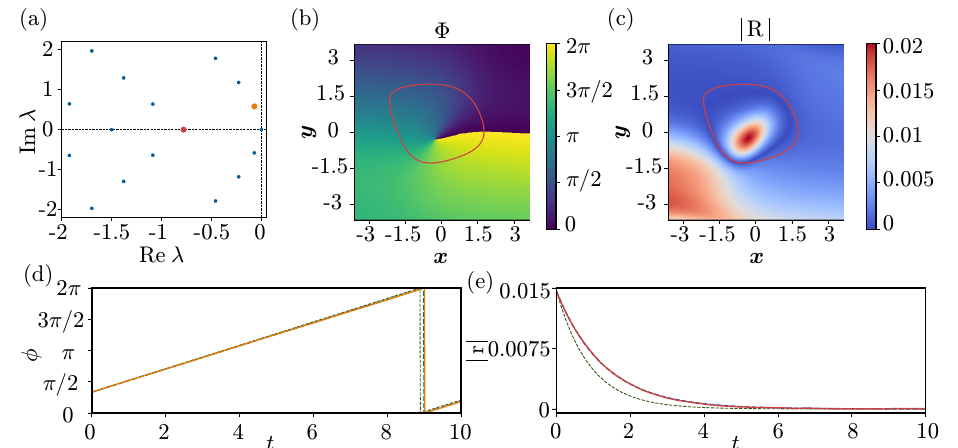
Figure 2. Phase and amplitude functions of a noisy FitzHugh–Nagumo model with parameter set (A). The deterministic vector field possesses a limit-cycle solution. ( a ) Eigenvalues of L + the imaginary axis. Orange and red dots represent Λ 1 and Λ 2 , respectively. ( b ) Phase function Φ . ( c ) Amplitude function | R | . ( d ) Evolution of averaged phase φ . ( d ) Evolution of averaged amplitude | r | . In ( b ), ( x , p ) = ( 1.5,0 ) is chosen as the phase origin. In ( b , c ), red-thin lines represent the deterministic limit-cycle solution. In ( d , e ), averaged results over 10,000 trajectories (orange and red thin lines) and analytical solutions (blue-dotted lines) for the stochastic case and results for the deterministic case (green-dotted lines) are